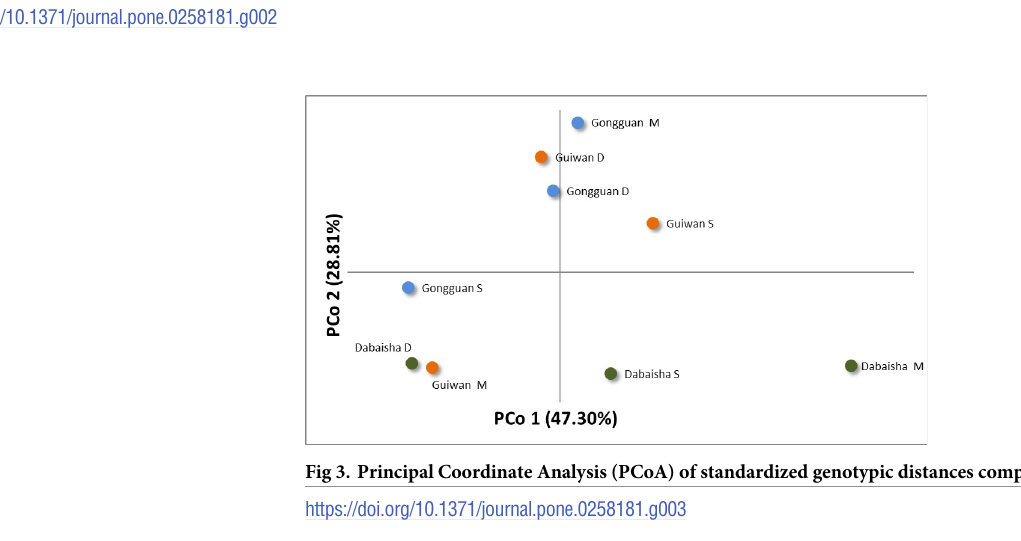
PLOS ONE | https://doi.org/10.1371/journal.pone.0258181 October 11,